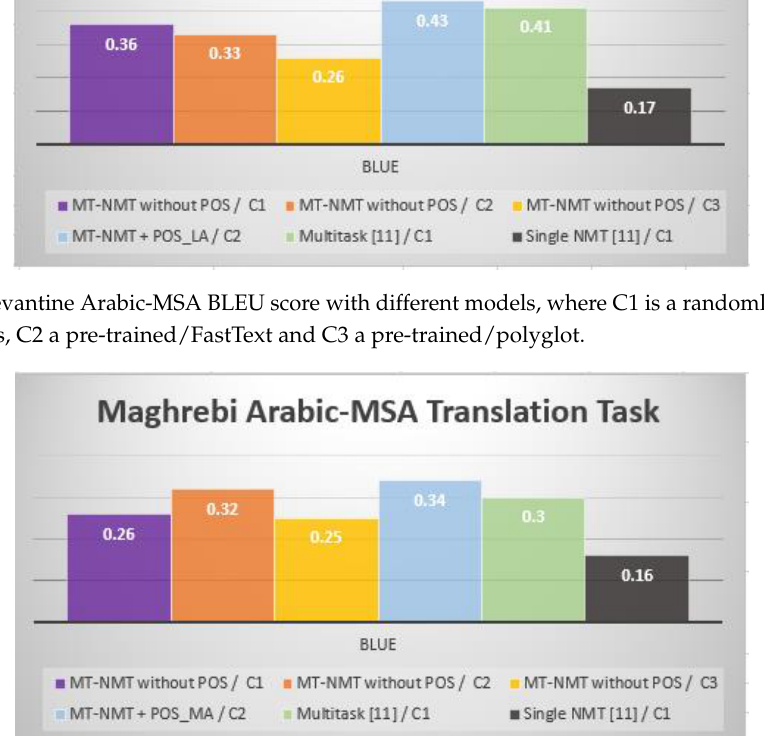
Figure 6. Maghrebi Arabic-MSA BLEU score with different models, where C1 is a randomly initialized embeddings, C2 a pre-trained/FastText and C3 a pre-trained/polyglot.